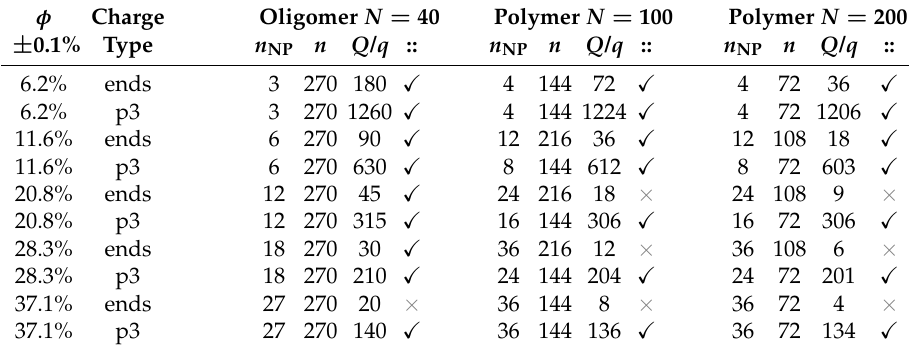
Table 2. Charged nanocomposite systems studied for matrices containing chains with N = 40, N = 100, and N = 200 beads. NP volume fraction φ (%), number n NP of spherical NPs of identical radius r NP , polymerization degree N , number of such chains n , and individual NP negative charge Q . Charge distribution on chains is denoted by the type attribute. Type ‘ends’ if all polymers chain ends (terminal beads) are charged, and ‘p3’ if every 3rd monomer is periodically charged along the polymer backbone (including chain ends), c.f. Figure 1a. The number of charges per polymer is n NP Q / n in each case. NP dispersion :: is detected for systems marked by a checkmark. This table is for systems with ε r = 24, while systems with ε r = 12 had been studied as well. The exact volume fractions are mentioned in the figures, for the purpose of this table they are precise by ± 0.1%. Neutral counterparts have been equilibrated in addition for all the listed